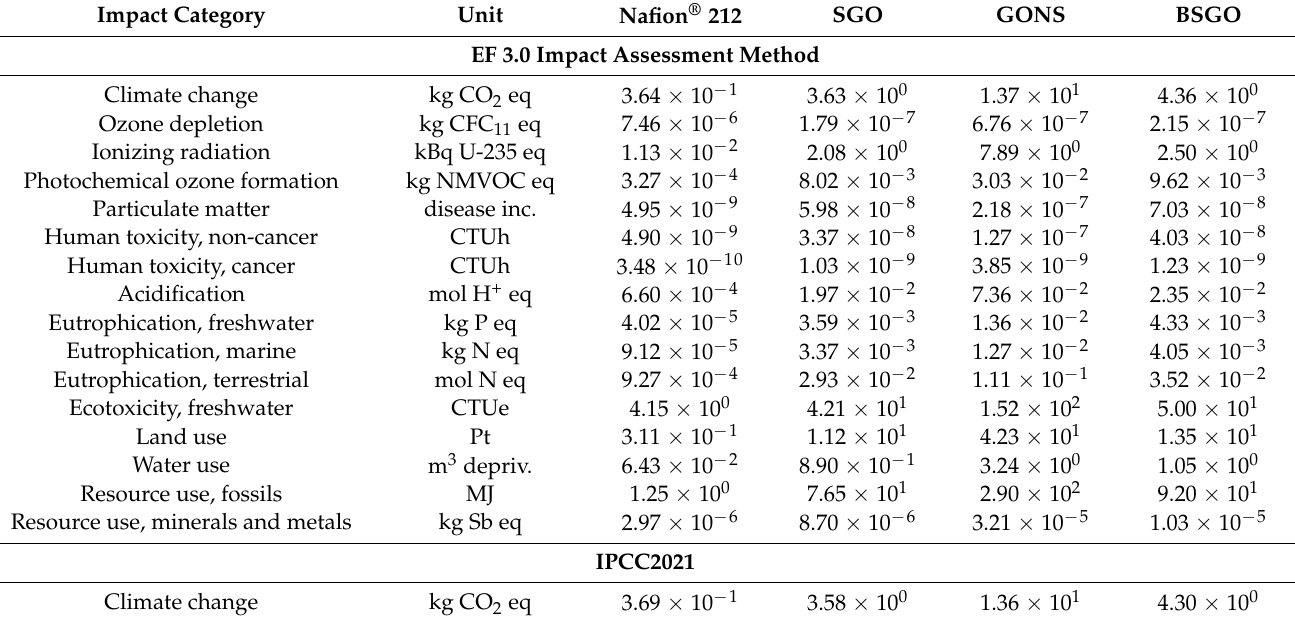
Table 1. Impact assessment results of Nafion ® 212, SGO, GONS, and BSGO per